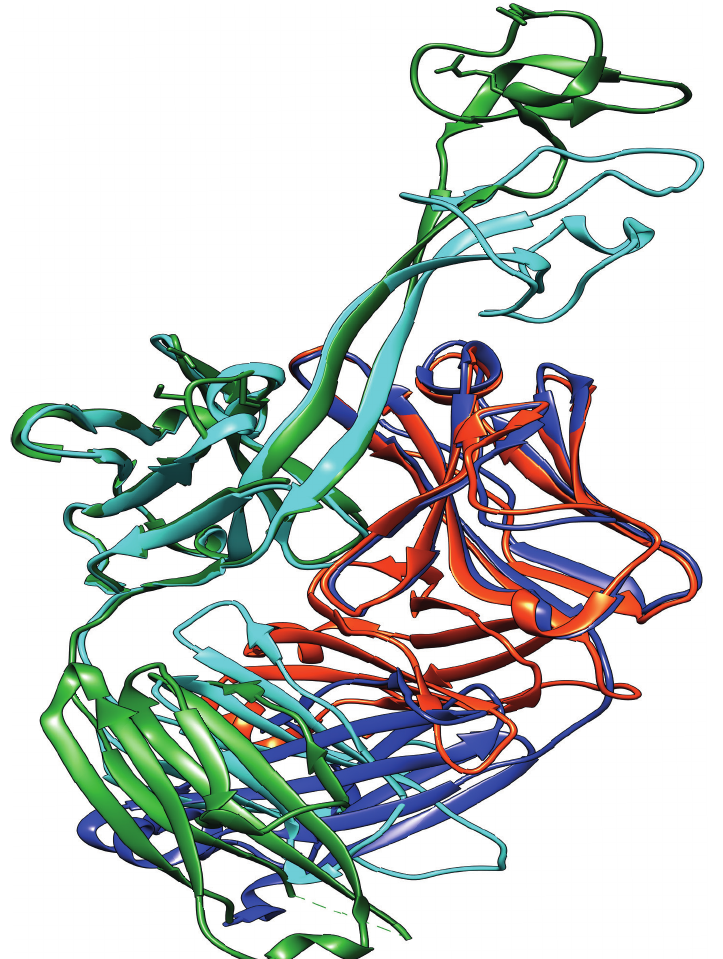
Figure 3. Diversity in the ultralong cow antibodies is focused in the knob domain. The overlay of the ribbon structures of two cow ultralong CDR H3 containing antibodies, BLV1H12 (heavy chain in green, light chain in dark blue; PDB: 4K3D) and Bov-7 (heavy chain in cyan, light chain in red; PDB: 6E9U). There is a 96% amino acid homology between the bulk of the two heavy chains, such that these regions of the overlaid structure have a root mean square error of 1.48 between equivalent α -carbons, as calculated by TopMatch [49]. In contrast, the knob domains are so divergent ( < 30% amino acid homology) that neither the amino acid sequences nor the 3D structures align